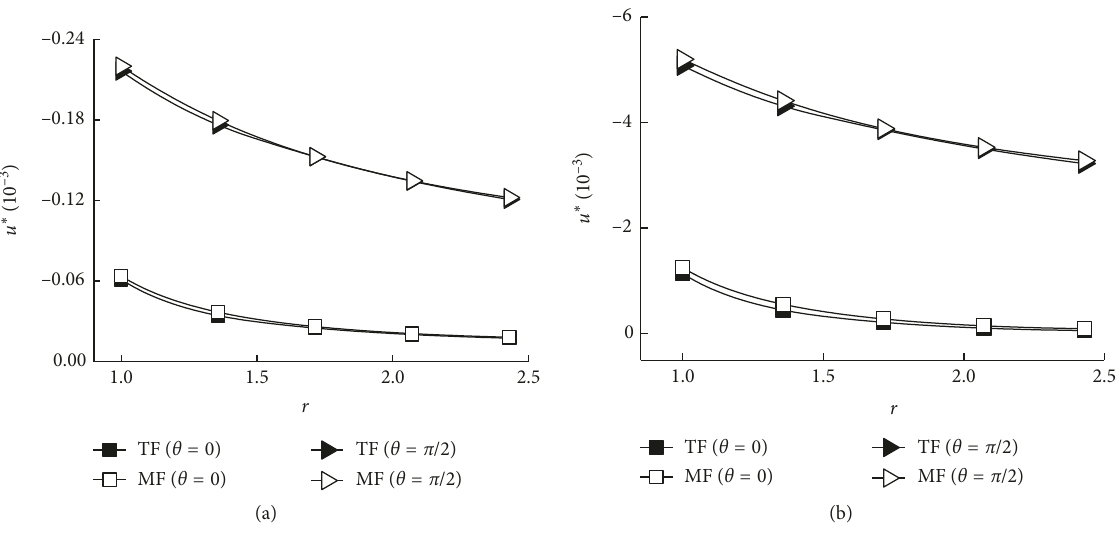
Figure 10: Graphs of u ∗ versus r for single-circle freezing: (a) frozen rock; (b) frozen soil.